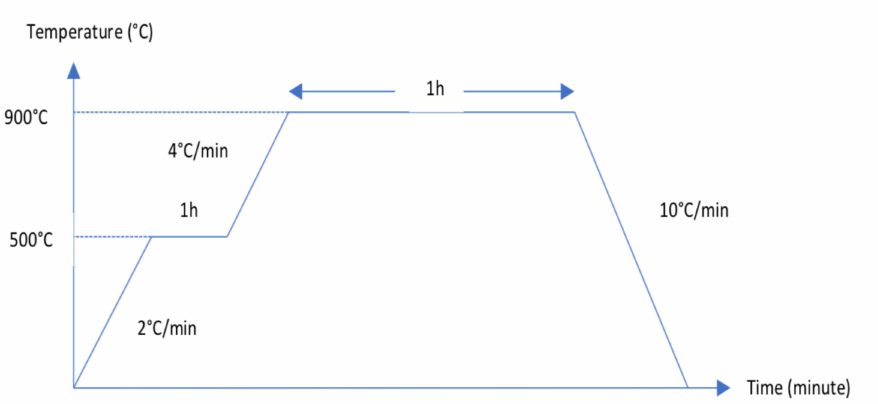
Figure 1. Two-step sintering profile for sintering the kaolin-ground granulated blast furnace slag (GGBS)